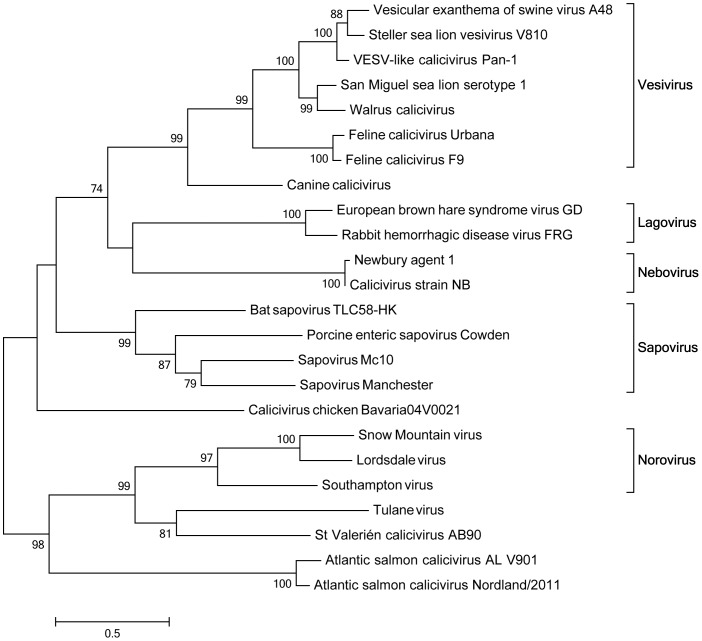
Evolutionary relationships of ASCV with members of the family Caliciviridae.Phylogenetic analysis was based on sequence regions encompassing the capsid or putative capsid of representatives of the five known genera of caliciviruses, suggested new genera and unassigned published viruses. Selected sequences were obtained from GenBank and present study and Neighbor-joining analysis was performed with 1000 bootstrap replicates, as described in Materials and Methods. Members of the family Caliciviridae included in the tree are as follows: Vesicular exanthema of swine virus (VESV) serotype A48 (NP786889); Steller sea lion vesivirus V810 (ABP88255); VESV-like calicivirus Pan-1 (AAC61759); San Miguel sea lion (SMSV) serotype 1 (AAG13639); Walrus calicivirus (NP786921); Feline calicivirus (FCV) Urbana (NP78331); Feline calicivirus (FCV) F9 (from AAA79327); Canine calicivirus (NP786912); European brown hare syndrome virus (EBHSV) GD (from CAA93445); Rabbit hemorrhagic disease virus (RHDV) FRG (NP740333); Newbury agent 1 (from YP529550); Calicivirus strain NB (AAT35531); Bat sapovirus (Bat-SaV) TLC58-HK (from AFJ39355); Porcine enteric sapovirus (PEC) Cowden (from NP051035); Sapovirus (SaV) Mc10 (YP052971); Sapovirus (SaV) Manchester (CAA60262); Calicivirus chicken Bavaria04V0021 (from ADN88287); Snow Mountain virus (AAN08112); Lordsdale virus (CAA60255); Southampton virus (AAA92984); Tulane virus (ACB38132); St Valerién calicivirus AB90 (from ACQ44559). Only bootstrap values of 60% and above have been displayed in the output.